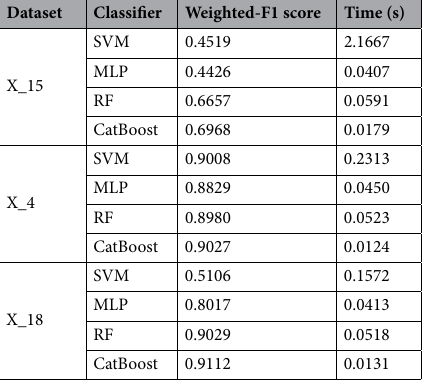
Table 5. Performance comparison of three classifiers in three datasets.